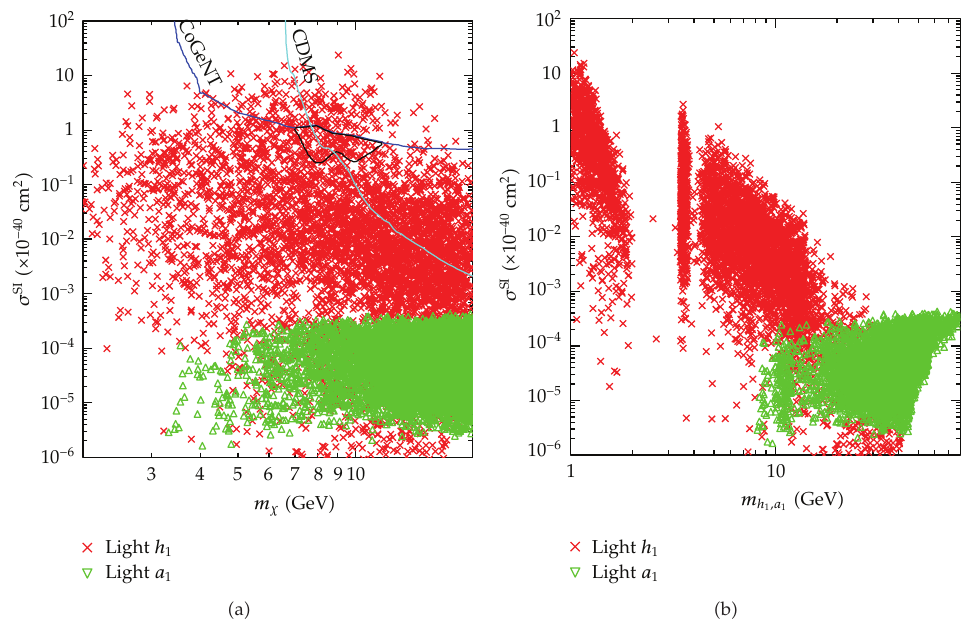
Figure 6: The scatter plots (cid:2) taken for (cid:5) 47 (cid:6)(cid:3) of the parameter samples which survive all constraints, with “ × ” (cid:2) red (cid:3) and “ (cid:2) ” (cid:2) green (cid:3) corresponding to a light h 1 and a light a 1 , respectively. The left frame is projected on the σ SI - m χ plane, while the right frame is projected on the σ SI - m h plane (cid:2) denoted by “ × ” (cid:3) and the σ SI - m a 1 1 plane (cid:2) denoted by “ (cid:2) ” (cid:3) . The curves are the limits from CoGeNT (cid:5) 41 (cid:6) and CDMS (cid:5) 38 (cid:6) , while the contour is the CoGeNT-favored region (cid:5) 41 (cid:6)